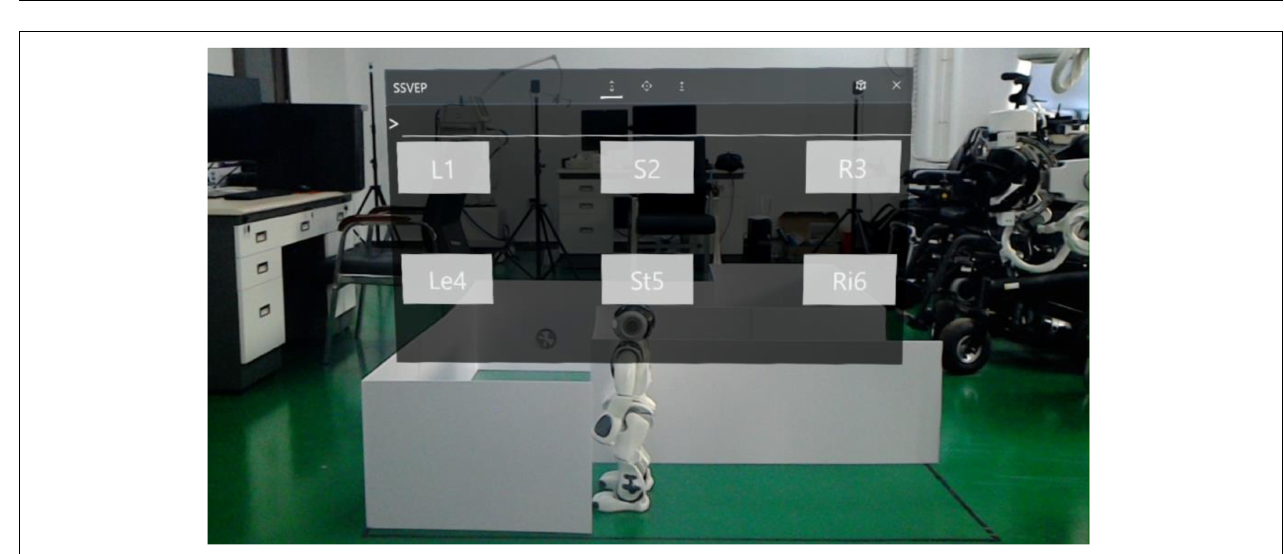
FIGURE 5 | Augmented reality controlling